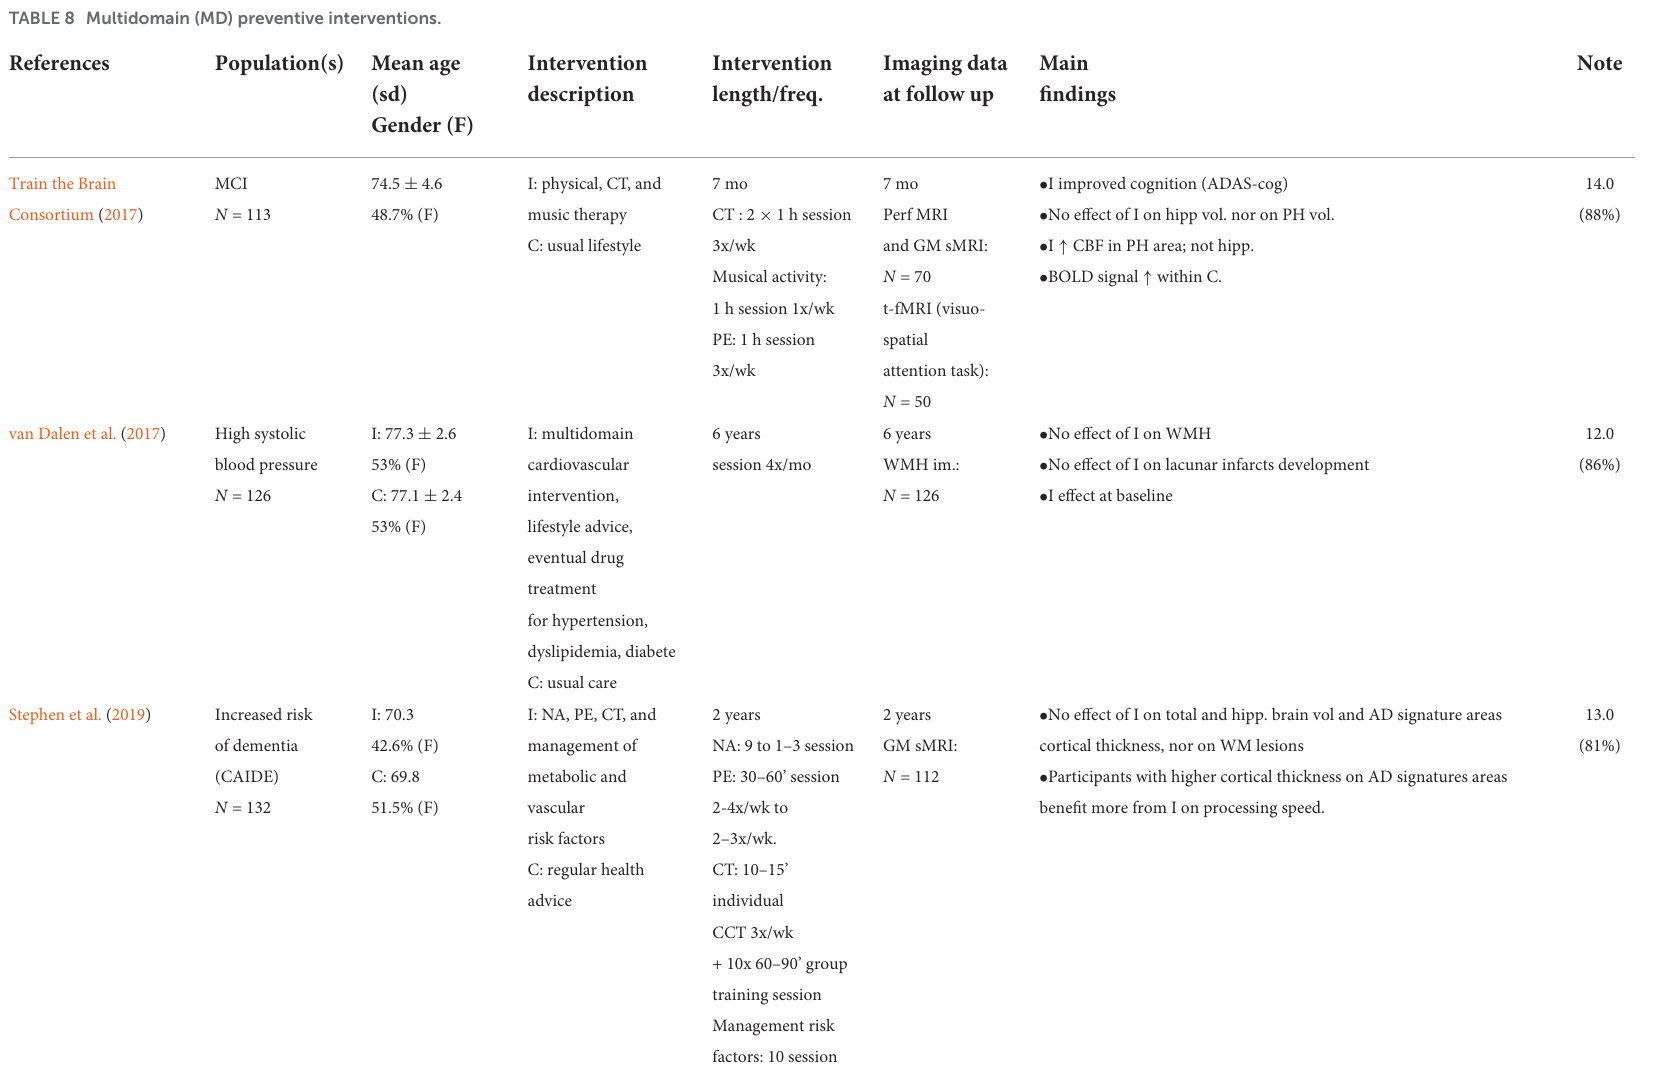
TABLE 8 Multidomain (MD) preventive